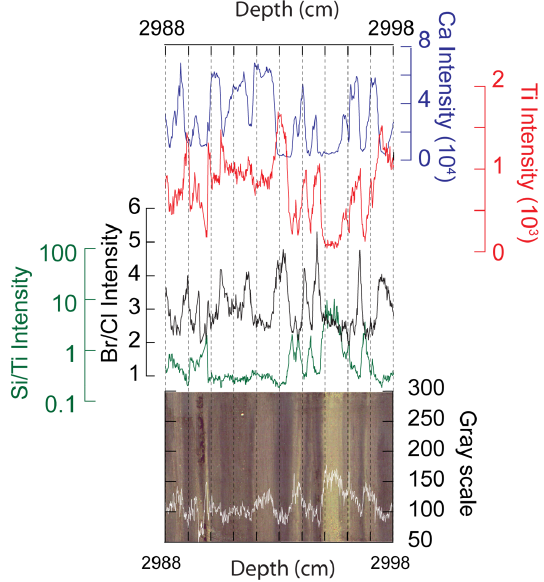
Fig. 3. The XRF intensities for Ca, Ti, Br/Cl, and Si/Ti (spatial resolution of 200µm) of a 10cm long sample of MD02-2508, repre- senting roughly 300yr of sediment deposition, and the correspond- ing photography of the core with gray scale analyses. Contrast and lightness of the image were slightly enhanced, and gray scale mea- surements were performed using ImageJ software. The position of the sample within the record is indicated with a red tick at the top of Fig. 2. Vertical dashed lines show 1cm intervals.